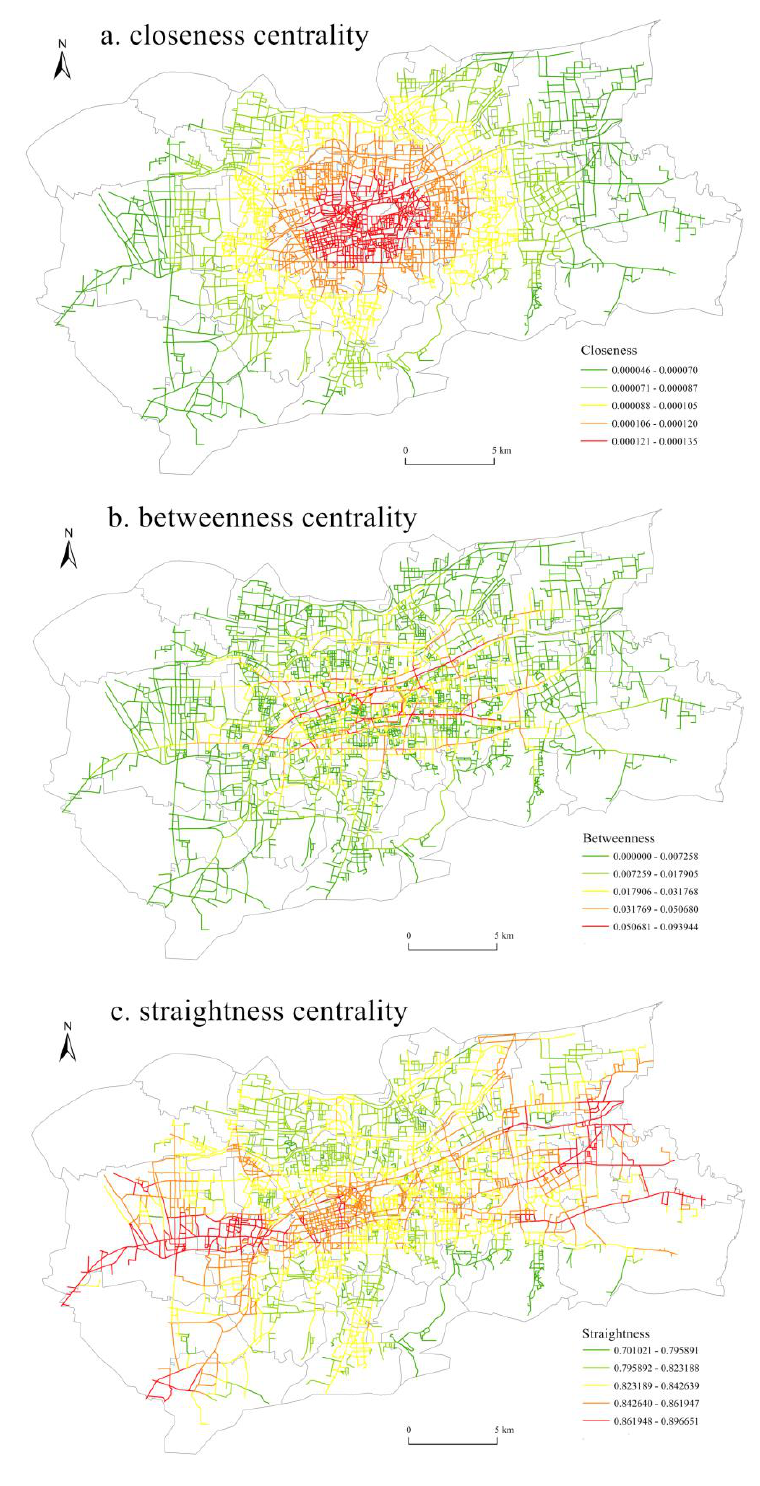
Figure 3. Spatial distribution of SC.